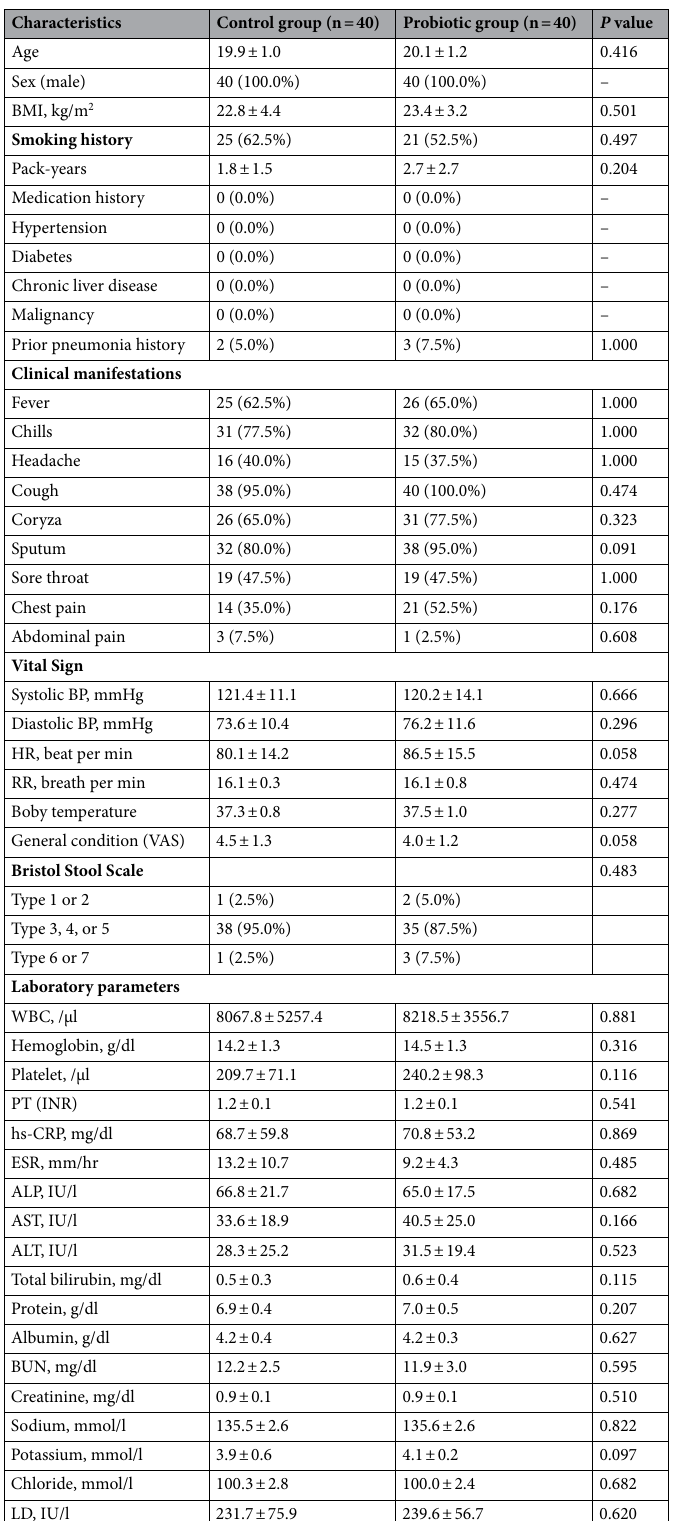
Table 1. Demographics and baseline clinical characteristics. BMI, body mass index; BP, blood pressure; HR, heart rate; RR, respiratory rate; VAS, visual analogue scale; WBC, white blood cells;